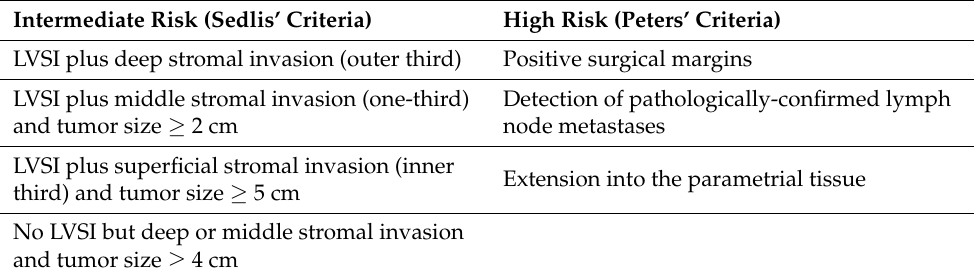
Figure 1. Clinical risk factors in cervical cancer. After primary, curatively intended surgery, Sedlis’ and Peters’ criteria were established to estimate the risk of pelvic and extra-pelvic recurrence. These risk factors include tumor size, deep stromal invasion, involved parametria, lymphovascular space invasion (LVSI) and the presence of lymph node metastases. Created with BioRender.com (accessed on 5 September 2021). Table 1. Clinical features and postoperative surgical and pathologic risk factors to assess the risk of recurrence in cervical